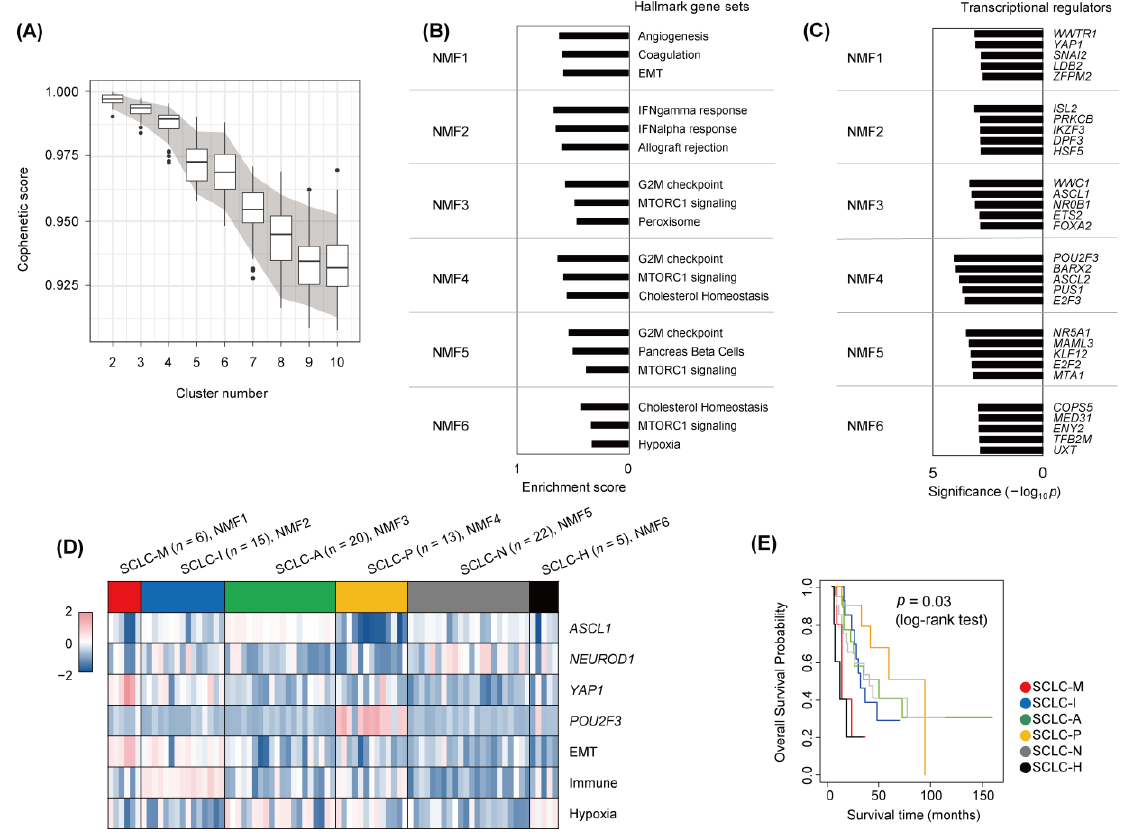
Figure 1. Transcriptional analysis to define SCLC subtypes. ( A ) Boxplots showing ranges of cophe- netic correlation coefficients ( y -axis) measured across K values (2 to 10; x -axis). Gray area indicates 90 percentiles (5% and 95%) of cophenetic scores per K value as obtained from permutation tests. ( B ) For six NMF clusters (NMF1 to NMF6), the top three enriched molecular functions (Hallmark gene sets in MSigDB) are shown with enrichment scores. ( C ) Cluster-specific transcriptional regulators are shown per NMF cluster. The level of significance was estimated by the VIPER algorithm and is shown on the x -axis ( − log 10 p ). ( D ) Six NMF clusters (NMF1 to NMF6) are annotated SCLC-M, -I, -A, -P, -N, and -H, respectively, according to the level of expression of four transcriptional regulators ( ASCL1 , NEUROD1 , YAP1 , and POU2F3 ) and the signature scores of three molecular functions (EMT, immune activity, and hypoxia). ( E ) Kaplan–Meier survival curves of overall survival are shown for the six SCLC subtypes. Significance was estimated by log-rank